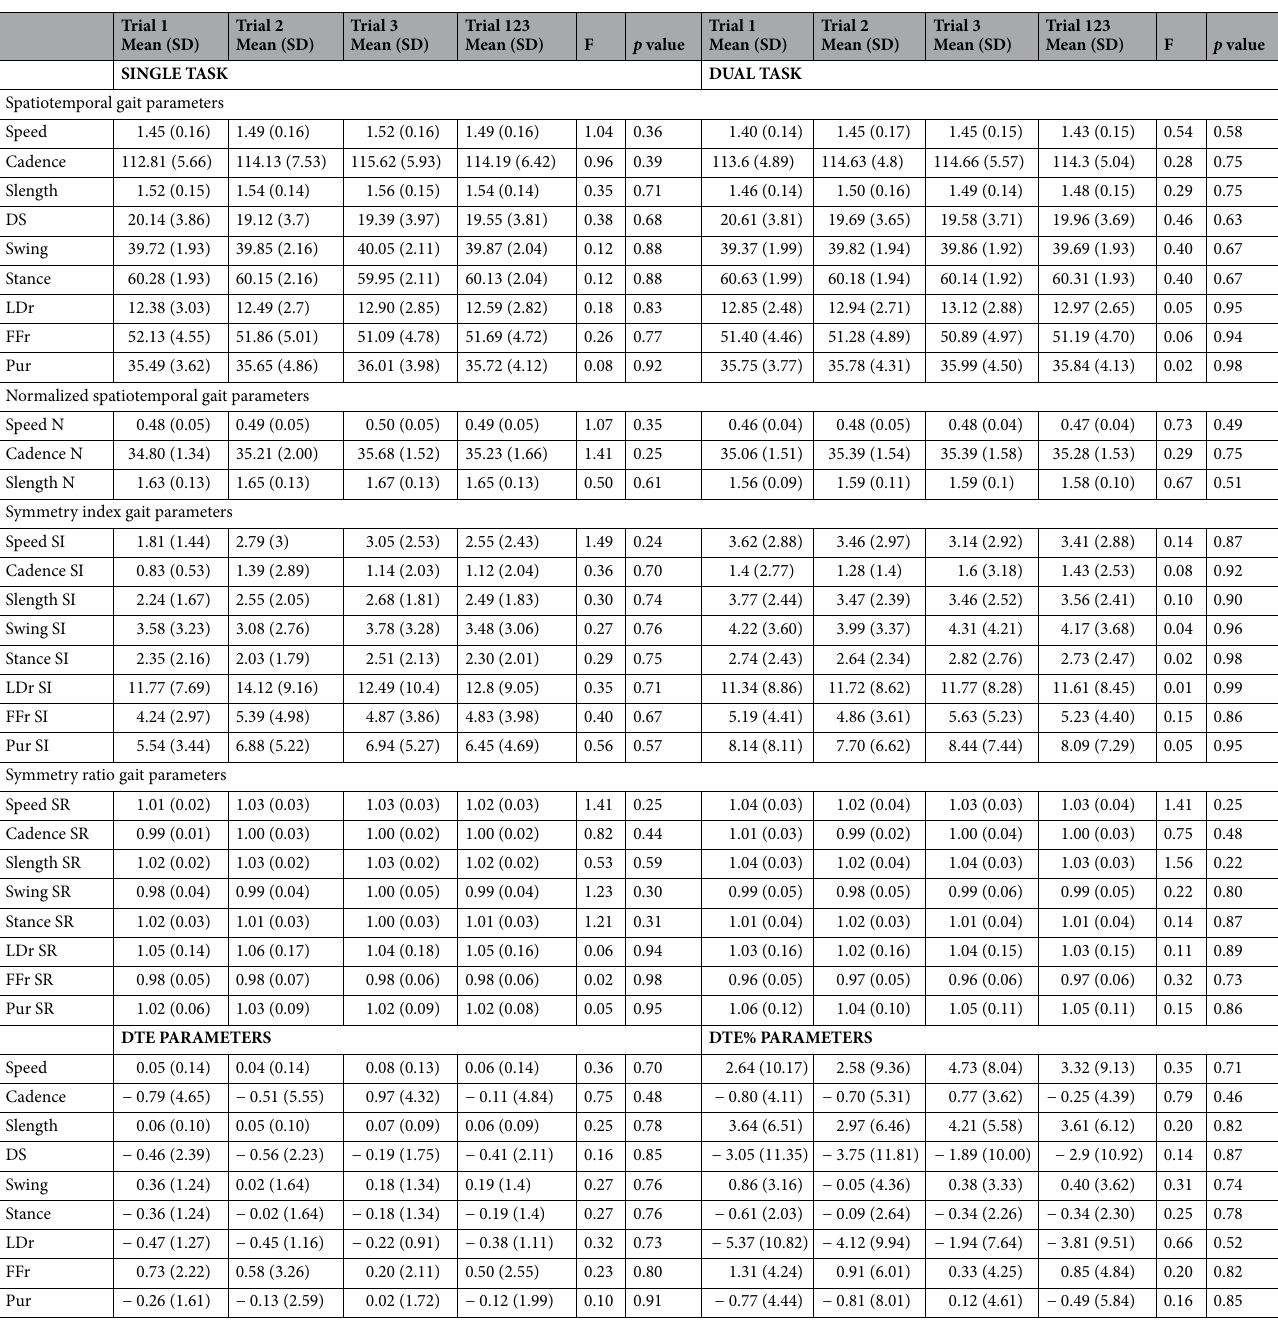
Table 1. Means and standard deviations of gait parameters for each trial and for the three trials, in the single- and dual-task conditions, and DTE and DTE% parameters, with p values obtained from RM-ANOVA to compare trials 1,2 and 3. Abbreviations: DS = double support, N = normalized, slength = stride length, LDr = Load Ratio, FFr = Foot flat ratio, Pur = Push ratio, SI = symmetry index, SR = symmetry